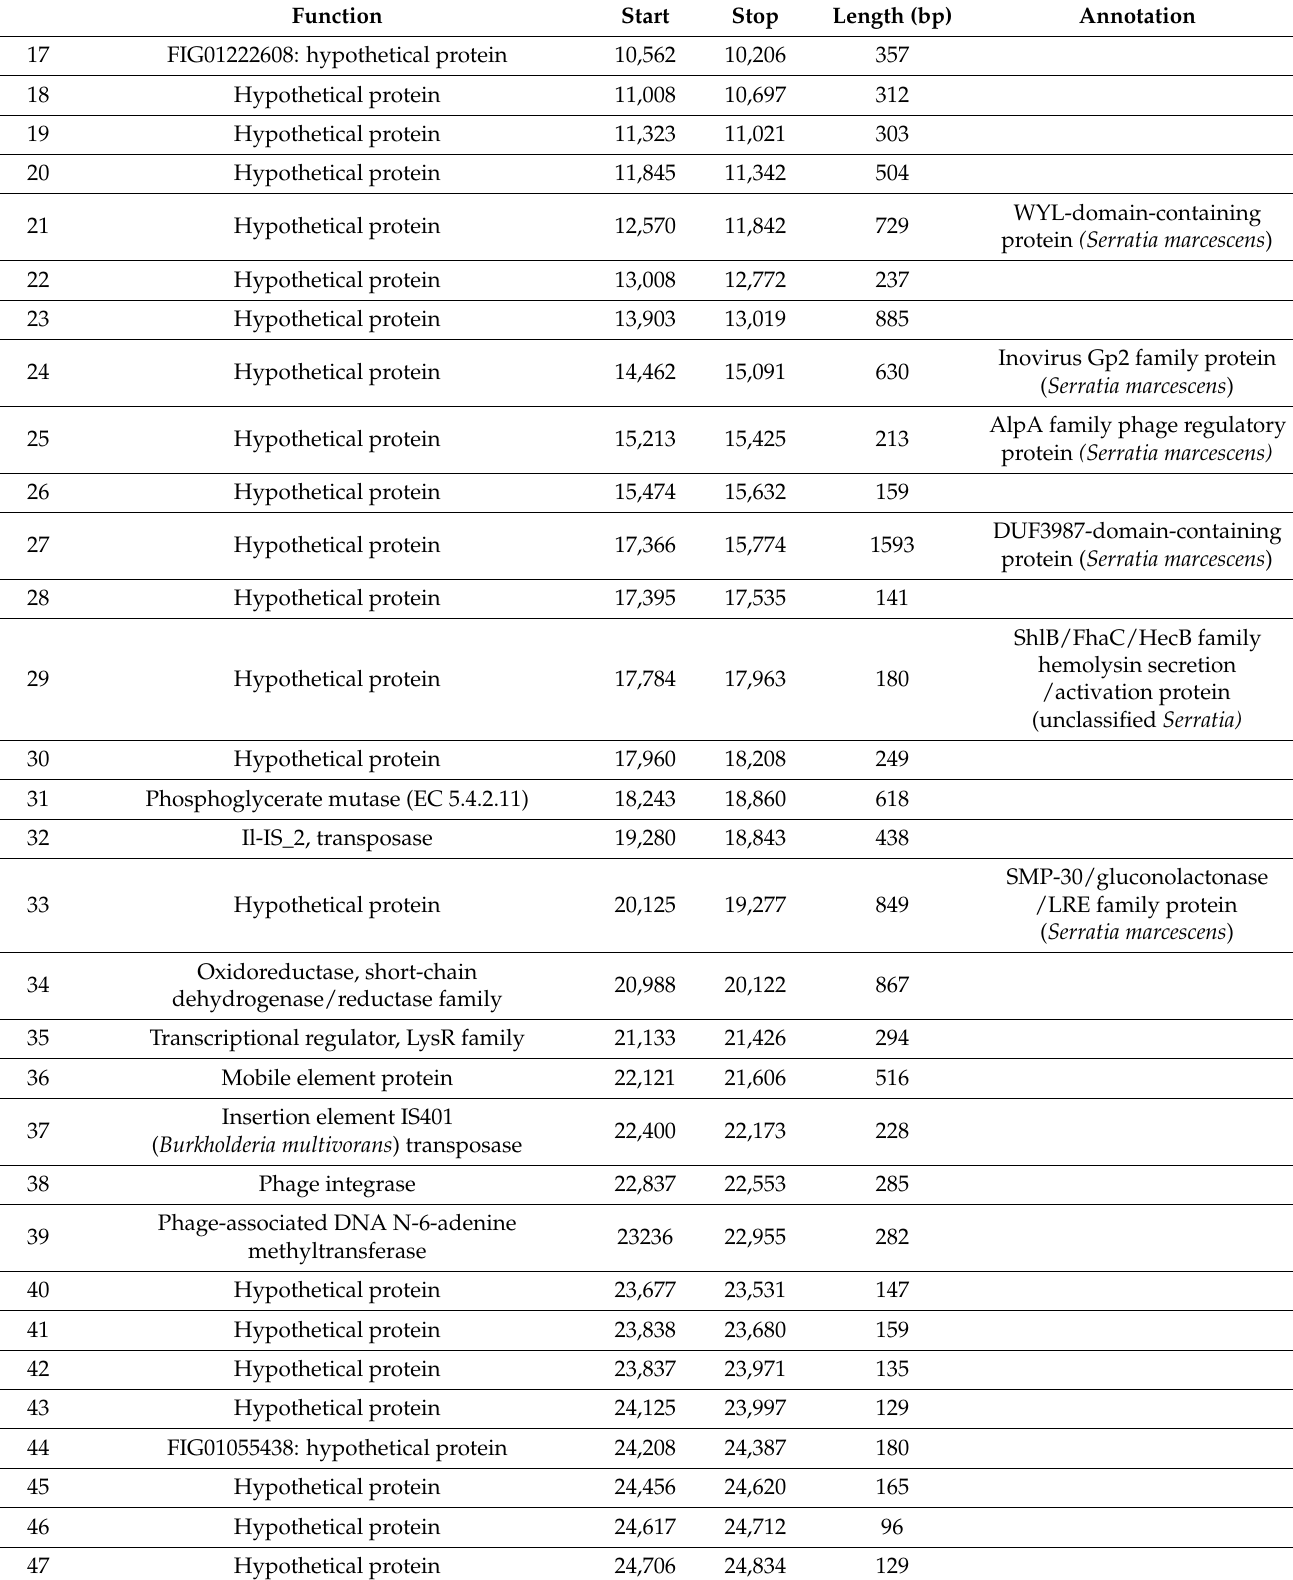
FIG01055438: hypothetical